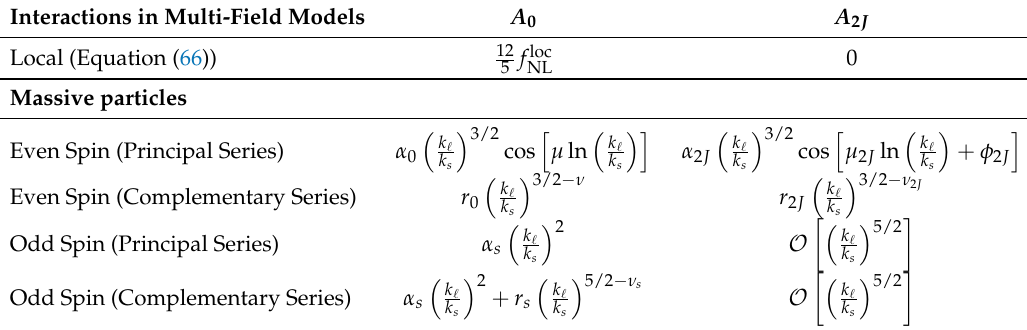
Table 2. List of values of A 2 J from the squeezed limit expansion of Equation (150) for interactions produced in multi-field models of inflation. We have parametrized the amplitude of interactions involving the exchange of massive particles using α s and r s , where s indicates the spin of the particle, for principal and complementary series, respectively. Full expressions for these amplitudes can be found in